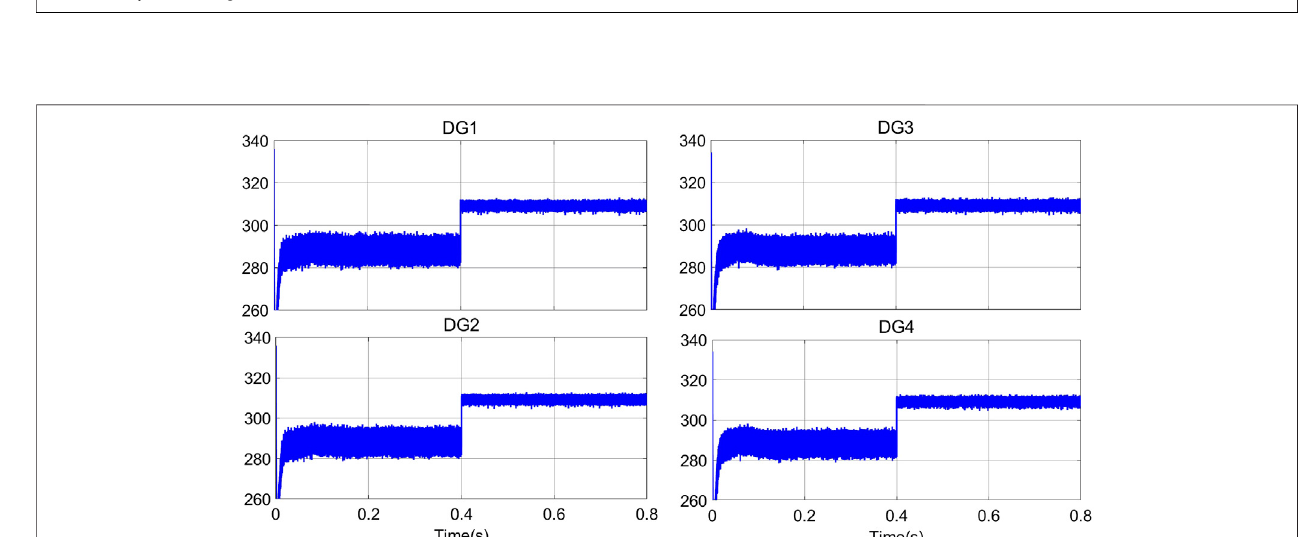
FIGURE 6 | d-component of load